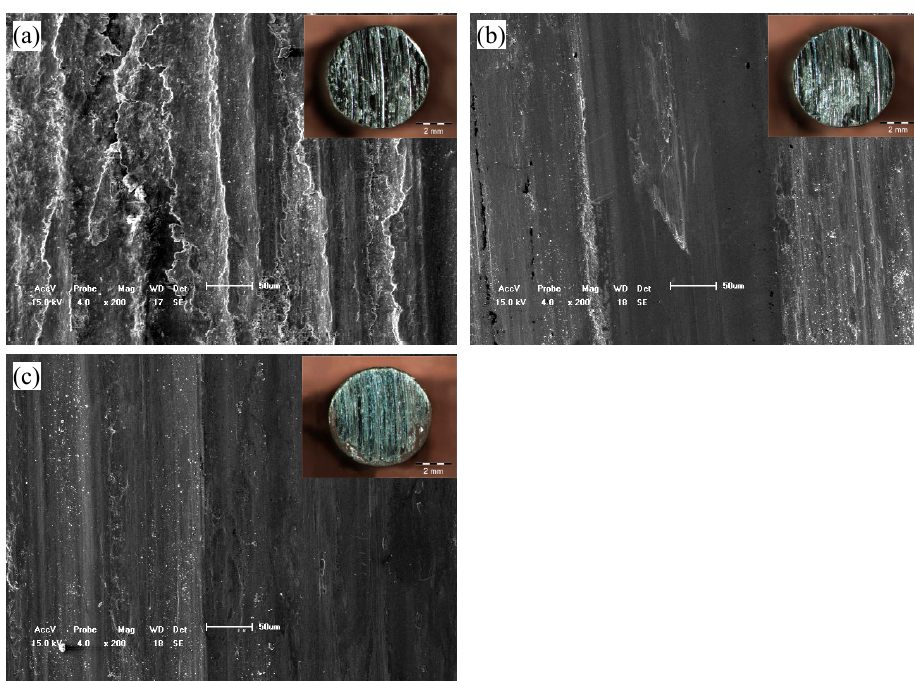
Figure 6. Morphologies of the worn surface of specimens after wear test. ( a ) The H13 substrate; ( b ) laser cladding coating without Y 2 O 3 addition; ( c ) laser cladding HEA coating with Y 2 O 3 addition. The insert on each image represents the overall morphology of the worn surface.